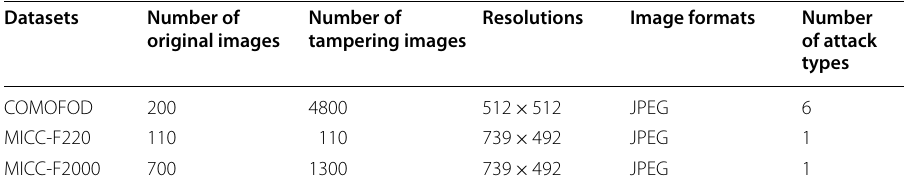
Table 1 Basic information on datasets used in the experiments Datasets